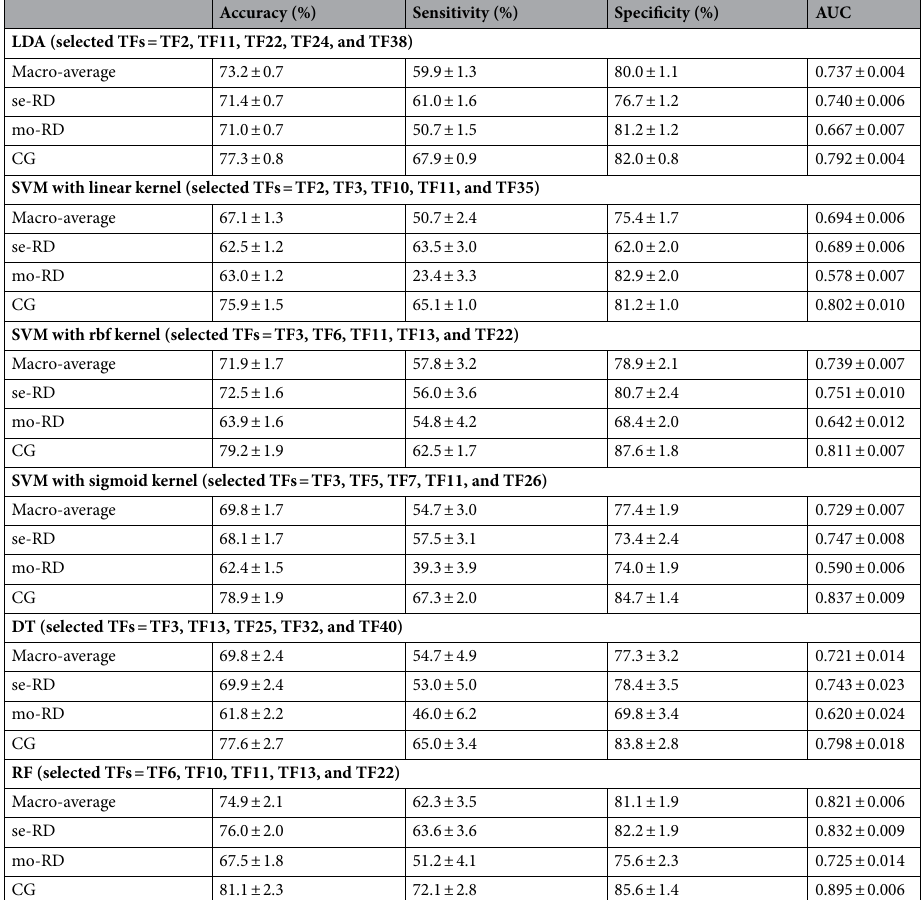
Table 7. Performance of each classification attempt in discriminating between the three groups in T2* map imaging. TF texture feature, DT decision tree, LDA linear discriminant analysis, SVM support vector machine, RF random forest classifier, AUC area under the curve, se-RD severe renal dysfunction (estimated glomerular filtration rate [eGFR] < 30 mL/min/1.73 m 2 , i.e., CKD stage G4–5), mo-RD moderate renal dysfunction (30 ≤ eGFR < 60 mL/min/1.73 m 2 , i.e., CKD stage G3a/3b), CG control group (eGFR ≥ 60 mL/min/1.73 m 2 , i.e., CKD stage G1–2). Feature name codes are as follows: TF2 = 90th percentile, TF3 = energy, TF5 = interquartile range, TF6 = mean absolute deviation, TF7 = mean, TF10 = root mean squared, TF11 = total energy, TF13 = difference average, TF22 = dependence non uniformity, TF24 = dependence variance, TF25 = gray level non uniformity (gray-level dependence matrix), TF26 = large dependence emphasis, TF32 = run length non uniformity, TF35 = run variance, TF38 = size zone non uniformity normalized, TF40 = zone percentage. The data are expressed as means ± standard